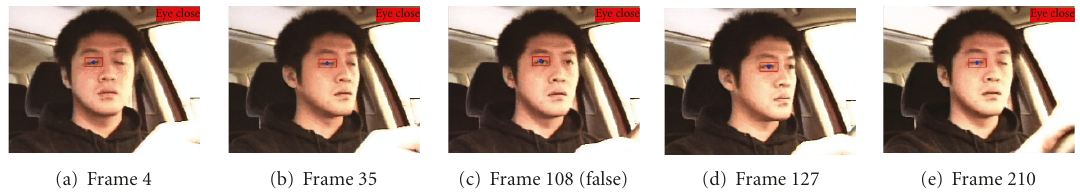
Figure 4: Examples of the blink detection results for in-car videos. Red boxes are tracked eyes, and the blue dots are the center of the eye locations. The red bar on the top-left indicates the presence of closed eyes.